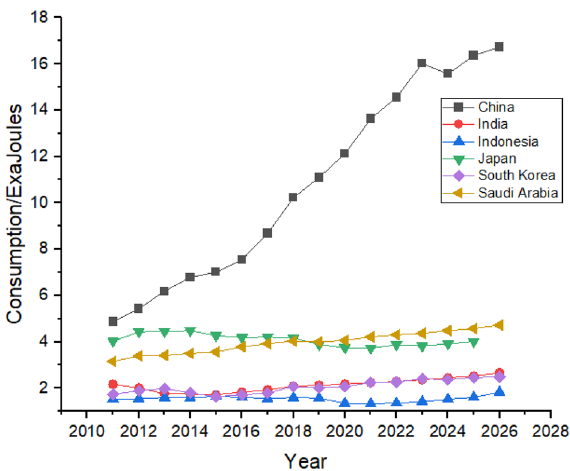
Figure 20. Natural gas consumption in Asian Region.